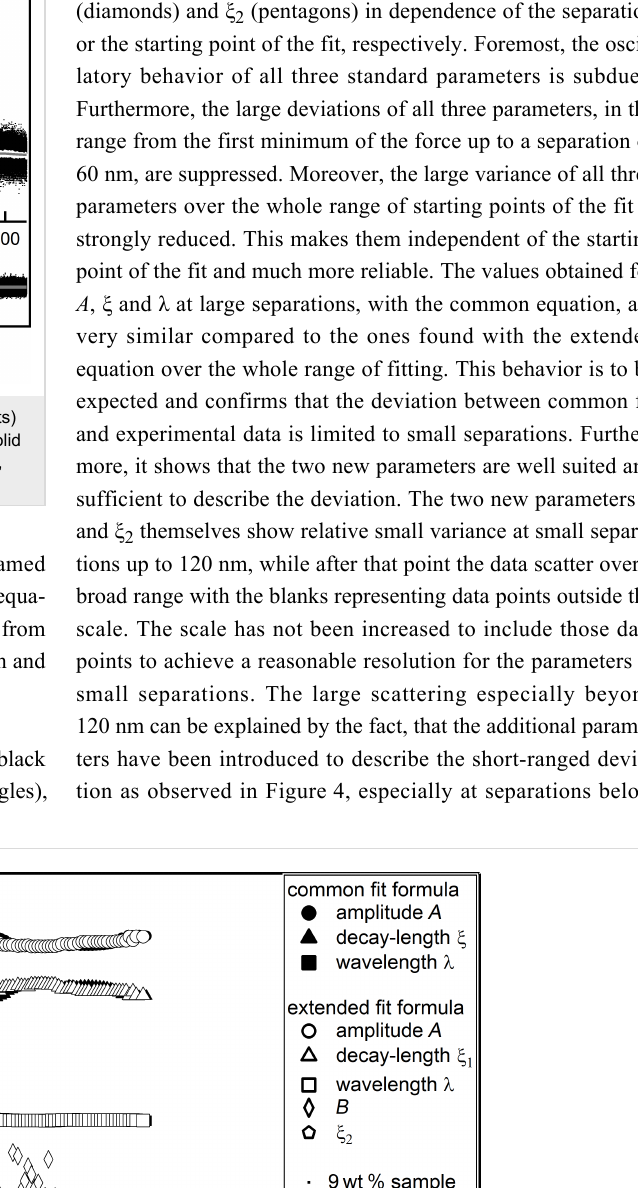
Figure 6: Combined force data of the 9 wt % suspension (black dots) together with the fit parameters over the separation or the starting point of the individual fit, respectively: A (circles), λ (squares) and ξ , ξ 1 (triangles), B (diamonds) and ξ 2 (pentagons). Open symbols represent parameters fitted with the new equation, while full symbols represent the data from Figure 3 for ease of comparison.